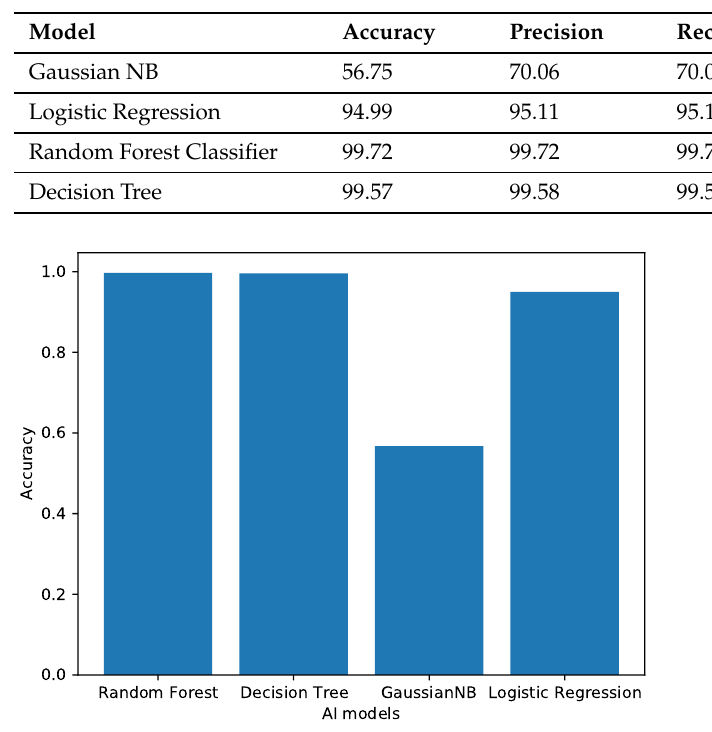
Figure 4. Accuracy graph for AI